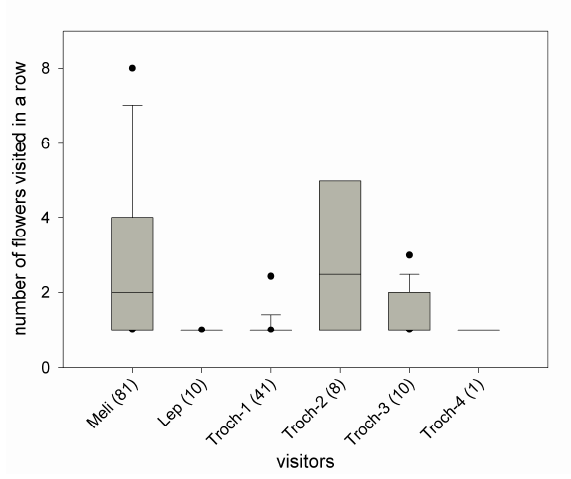
F IG . 1. Box-plots showing the number of H. angusta flowers visited in a row by each visitor species per 20min observation period